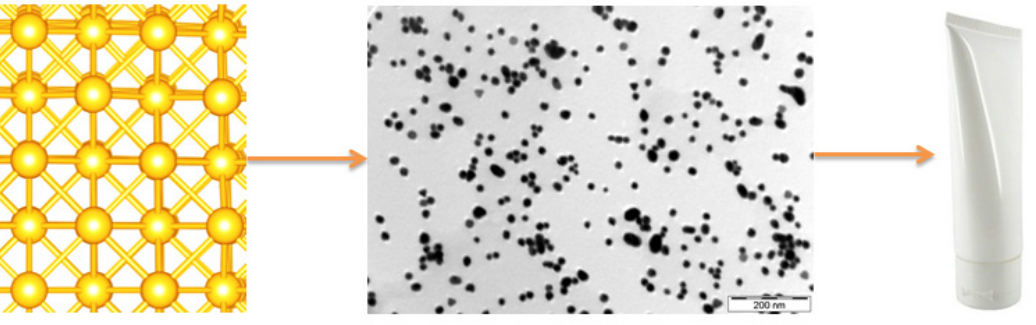
Figure 2. Gold nanoparticles use in cosmetic products.